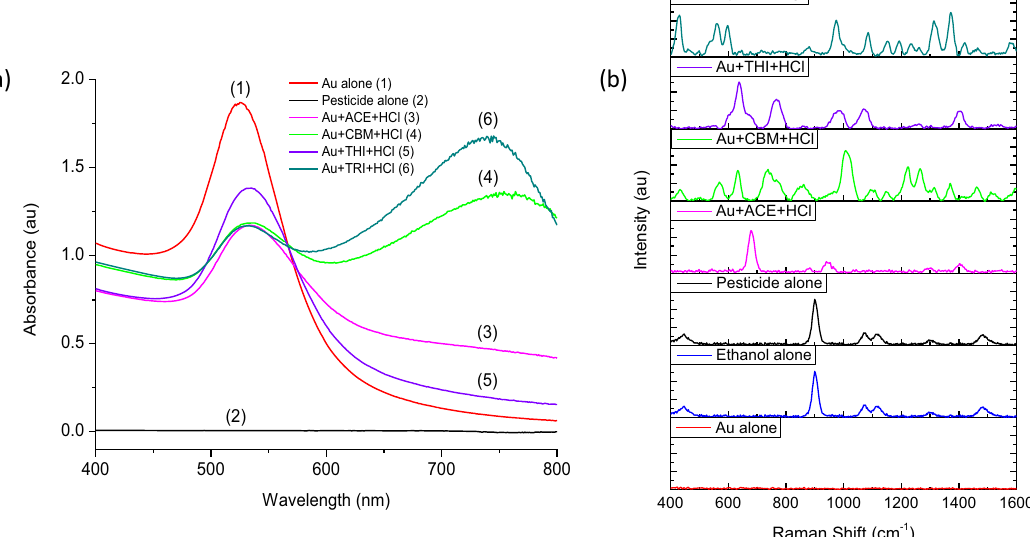
Fig. 3 Stability of colloidal AuNPs ( λ max = 528 nm) and corresponding SERS spectra in the presence of pesticides and HCl (2 M). a UV – vis spectra of (1) Au alone, (2) pesticide alone, AuNPs in the presence of HCl (2 M) and (3) acephate (ACE), (4) carbendazim (CBM), (5) thiamethoxam (THI) and (6) tricyclazole (TRI). b SERS ‘ fi ngerprint ’ spectra for Au alone (red line), ethanol alone (blue line), pesticide alone (black line), AuNPs in the presence of HCl (2 M) and ACE (pink line), CBM (green line), THI (purple line) and TRI (dark cyan line). Pesticide alone (black line) is the Raman spectra for CBM at 100 ppm and con fi rms that no ‘ fi ngerprint ’ SERS spectra can be obtained unless AuNPs are present (green